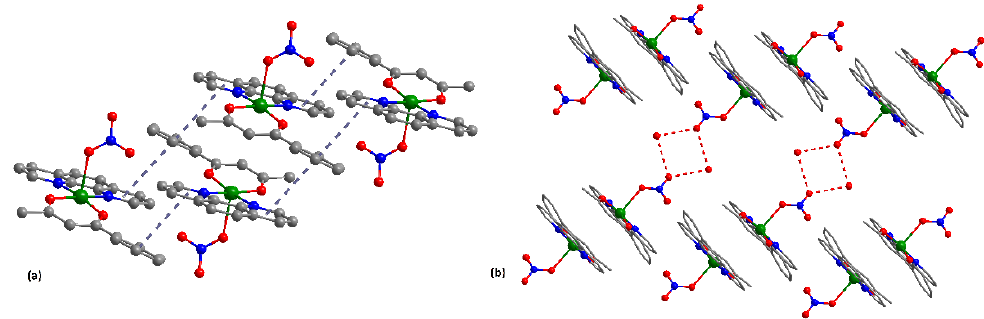
Figure 3. Supramolecular architectures formed through π - π stacking interactions ( a ) and hydrogen bonds ( b ) in ( 2 ). bonds ( b ) in ( 2